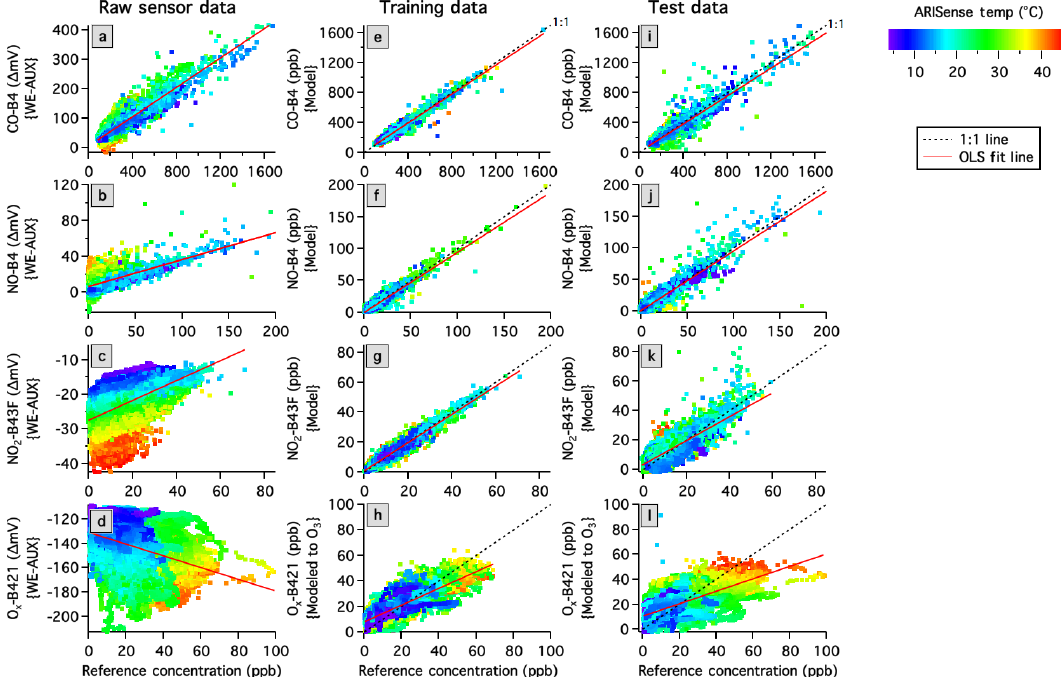
Figure 4. Correlation plots for all electrochemical sensors versus reference measurements for (a–d) raw sensor differential voltage sig- nals, (e–h) model output concentrations for the training data ( ∼ 25% of data), and (i–l) model output concentrations for test data (remaining ∼ 75% of data). All data shown are 5min average values with each data point colored by flow-cell temperature. The linear regression fit line (solid red line) is shown in all panels, and a 1 : 1 line (dashed black line) is shown in panels (e) – (l) . Table 2. Performance metrics for model output versus reference measurements for training data. Sensor N datapoints Y intercept Slope r 2 RMSE MAE MBE f ∗ train (ppb) (ppb) (ppb) (ppb) (%) CO-B4 7974 9.19 0.96 0.96 0.02 27.0% NO-B4 7974 0.46 0.94 0.94 NO 2 -B43F 7874 0.80 0.94 0.94 1.73 − 0.05 23.6% O x -B421 9071 8.34 0.65 0.65 8.24 6.22 0.03